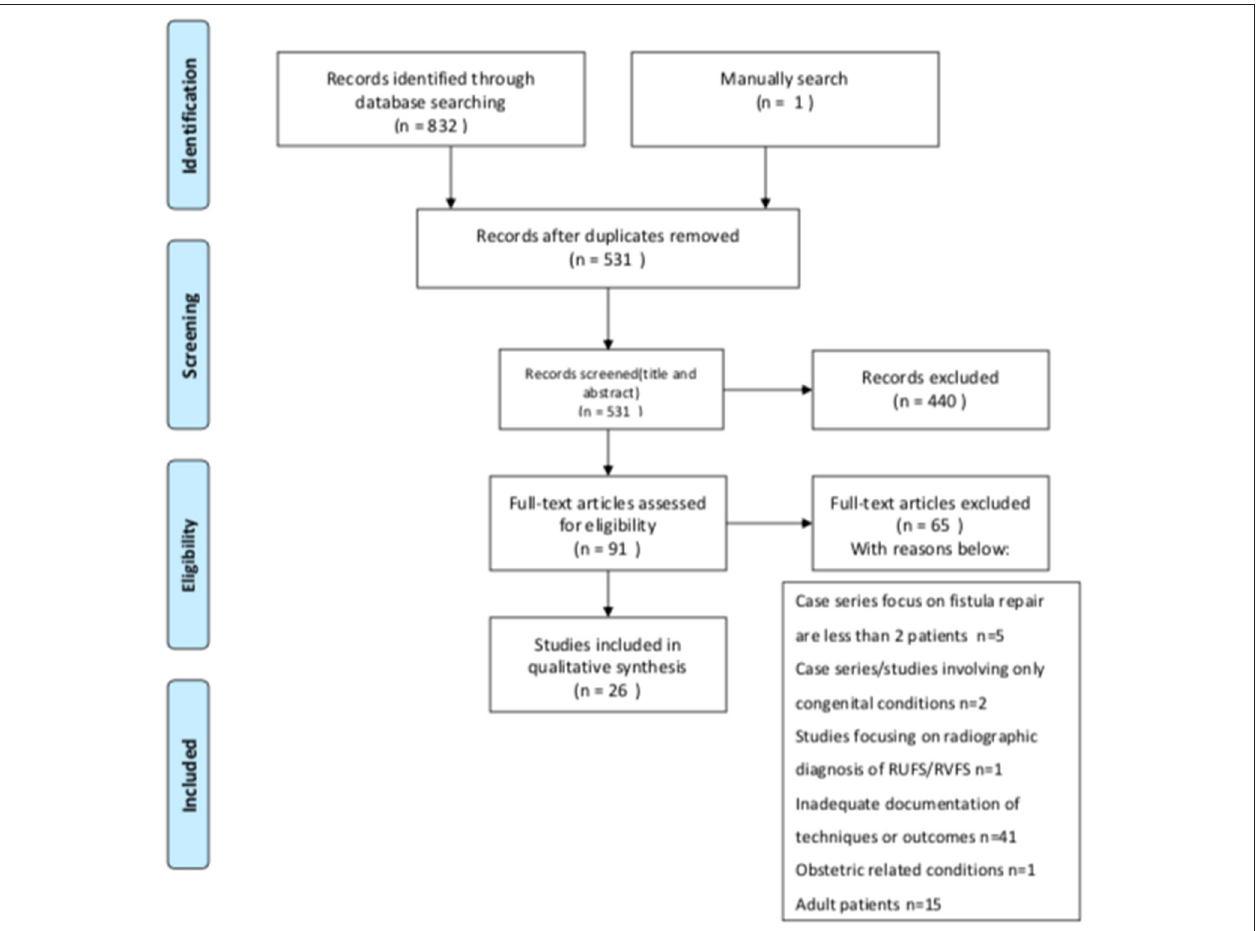
FIGURE 1 | PRISMA search flow